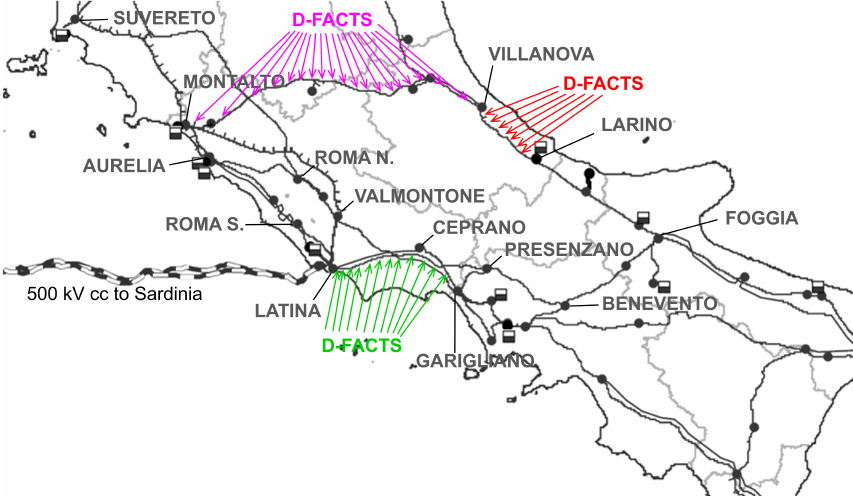
Figure 6. Portion of the Italian 380 kV transmission grid (Central-Southern